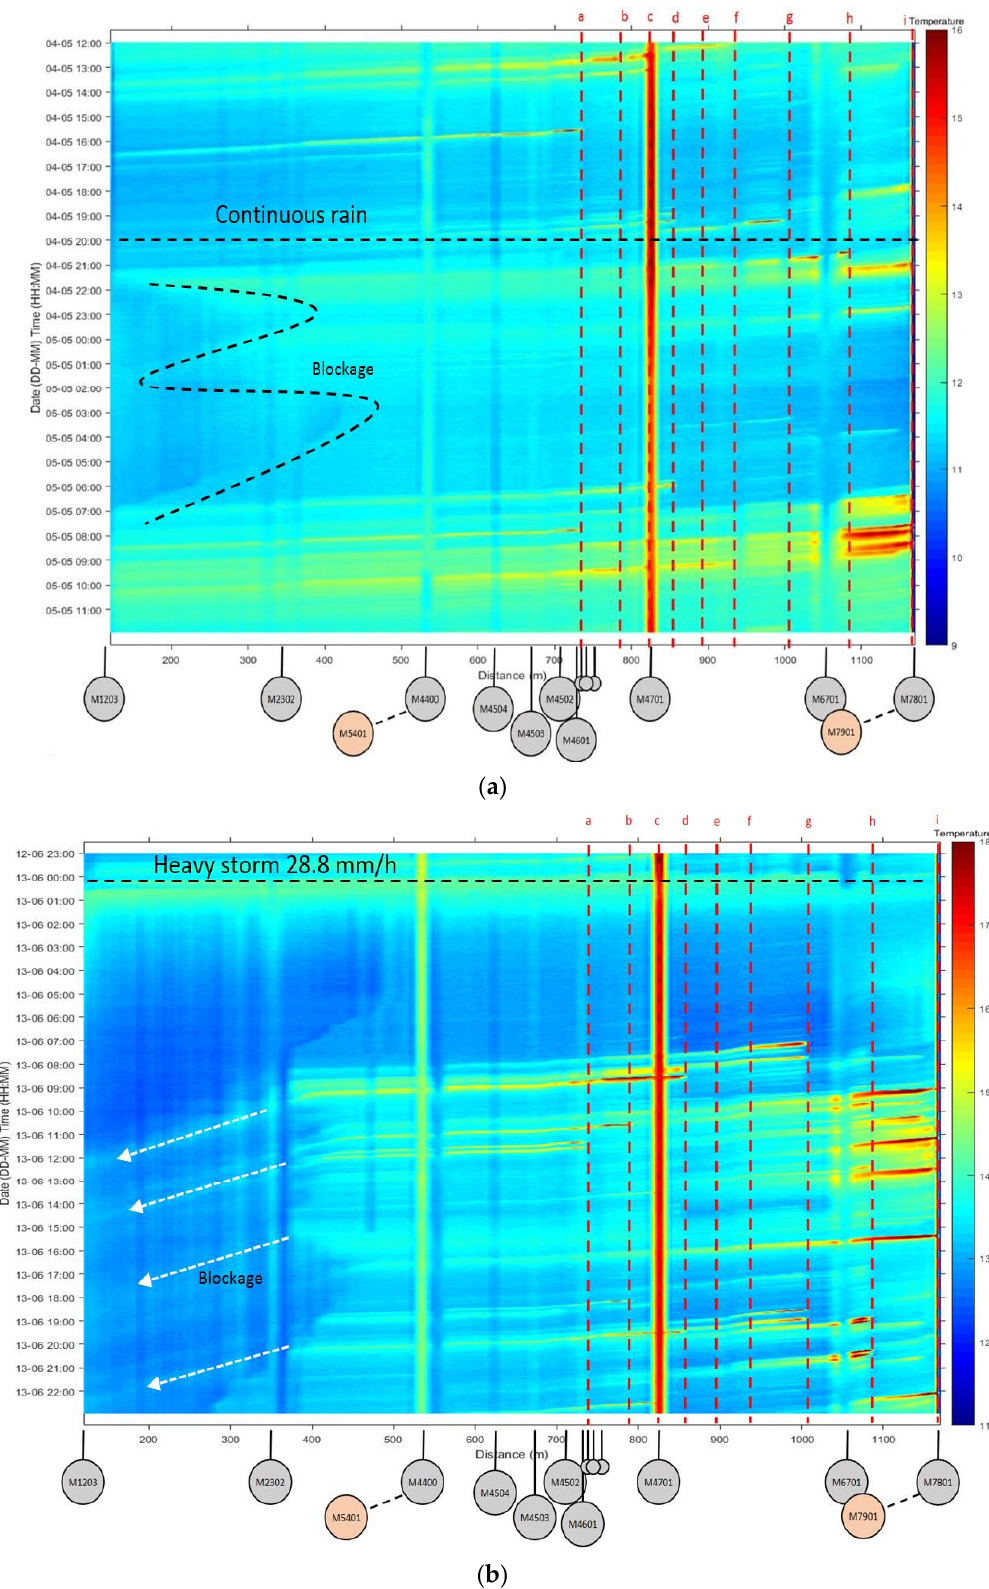
Figure 6. DTS monitoring results with serious blockage: ( a ) continuous moderate rain; ( b ) heavy rain.